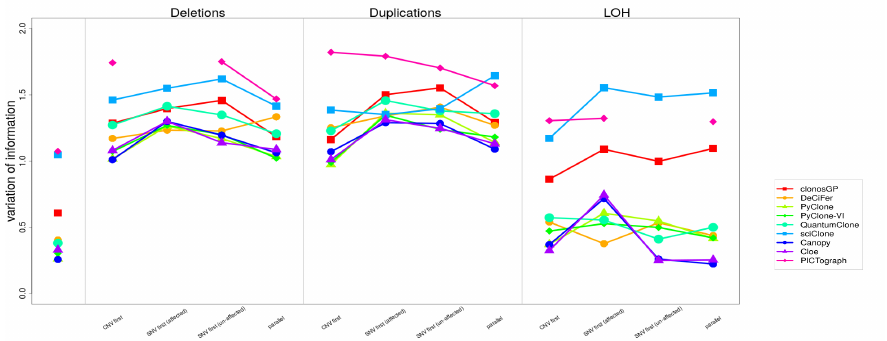
Figure 4. Variation of information comparing variant clustering performed using clonosGP, DeCiFer, PyClone, PyClone-VI, QuantumClone, sciClone, Canopy, Cloe, and PICTograph in the presence of CNVs to simulated truth. We evaluate the influence of deletions, duplications, and LOH, considering four scenarios of overlap: CNV first, SNV first (affected), SNV first (un-affected), and parallel. For comparison, the performance of each tool at the baseline configuration is included. Of note, a missing dot indicates missing clustering results for all 10 patients per simulated data